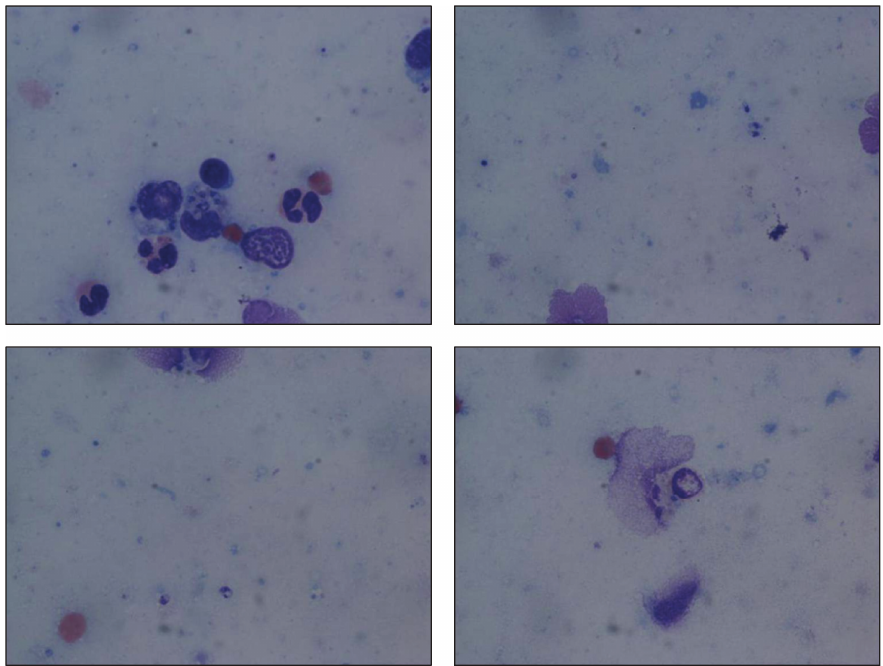
Figure 2: H&E smear: intact macrophages filled with Leishmania amastigotes also with visible nucleus and